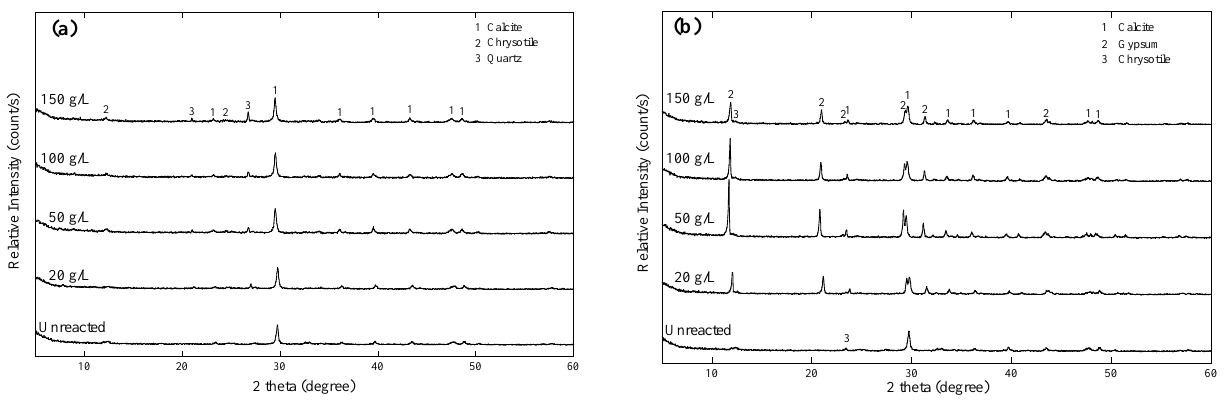
Figure 5. X-ray diffraction (XRD) patterns of as-received waste slate (Unreacted) and reacted waste slate samples obtained from leaching tests using the ( a ) 1 M CH and ( b ) 1 M NH HSO solutions at various solid dosages (20, 50, 100, and 150 4 4